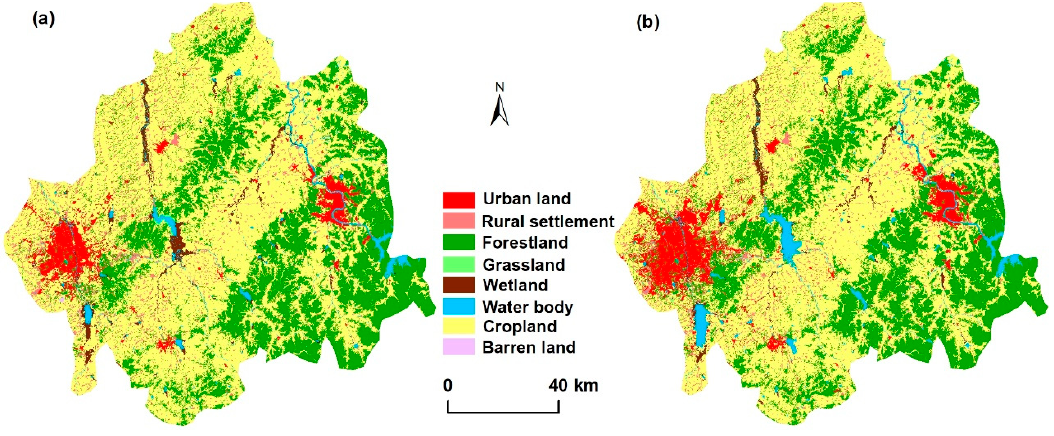
Figure 2. Land cover map of the CJEZ in 2000 ( a ) and 2015 ( b ).